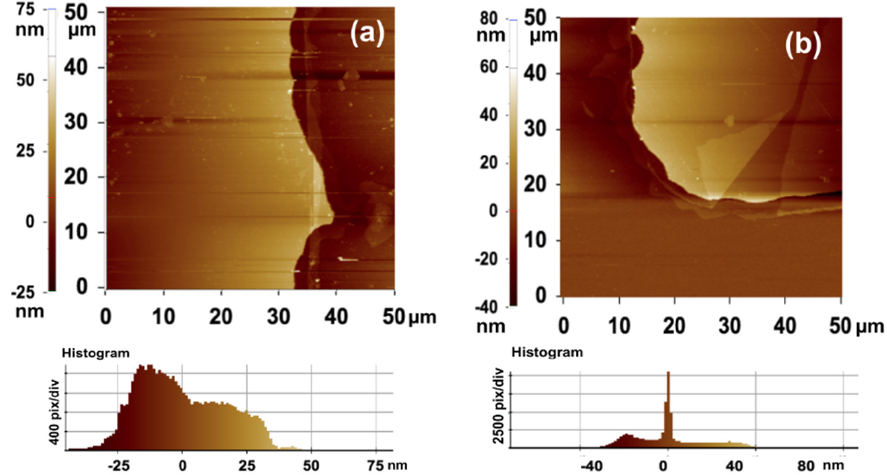
Figure 4. SEM images of ( a ) GO ( b ) Mn x Zn 1 − x O and ( c ) GO-Mn x Zn 1 − x O. Figure 5. AFM height profile of ( a ) comb-step thickness and ( b ) comb-edge height profile.